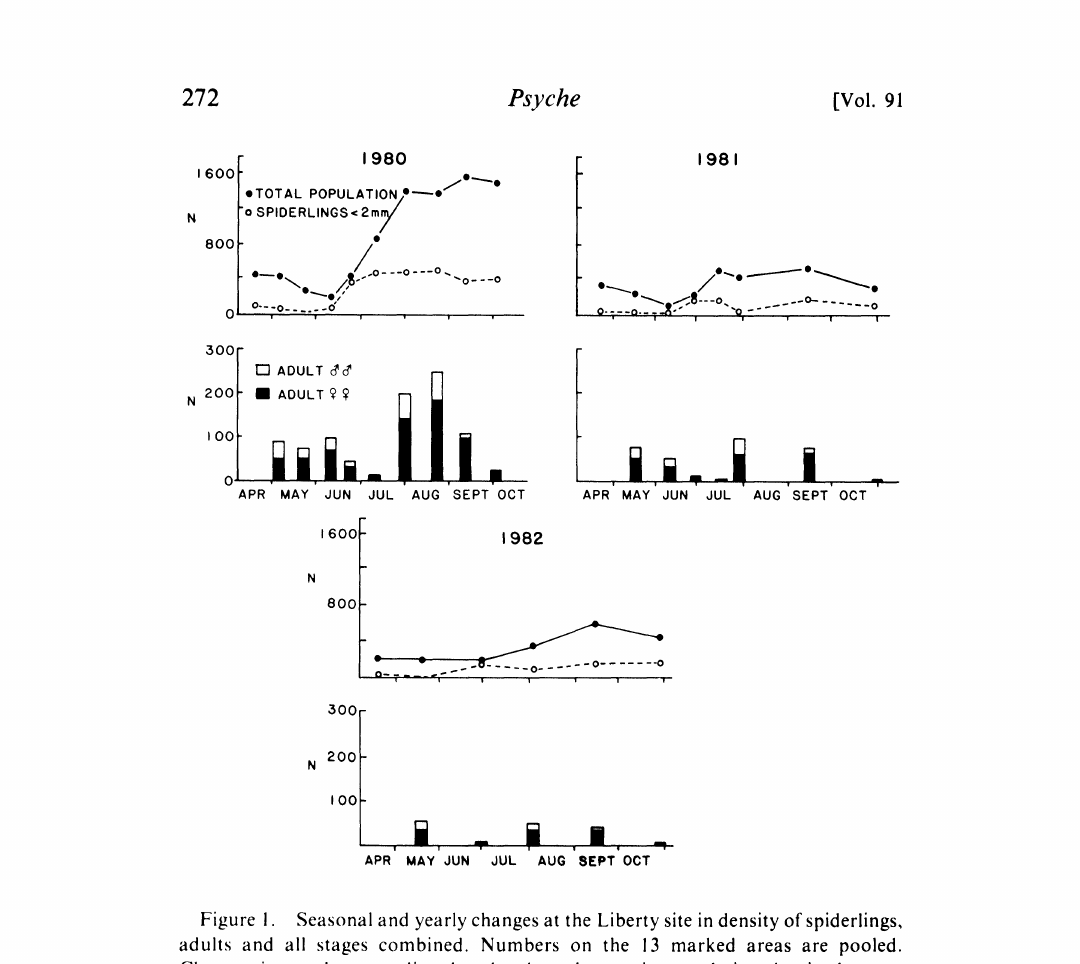
Figure 1. Seasonal and yearly changes at the Liberty site in density of spiderlings, adults and all stages combined. Numbers on the 13 marked areas are pooled. Changes in numbers are directly related to changes in population density because these same areas were censused each date. Although censuses were not conducted as frequently in 1982, they were made often enough to reveal a pattern similar to that of previous years: scarcity of adults at the end of June and an increase by early August. and sumvner in number of eggs reflected seasonal differences in female size and egg size. However, the eggs laid by summer females were significantly larger than spring eggs even after correction had been made for the negative correlation with egg number (Table